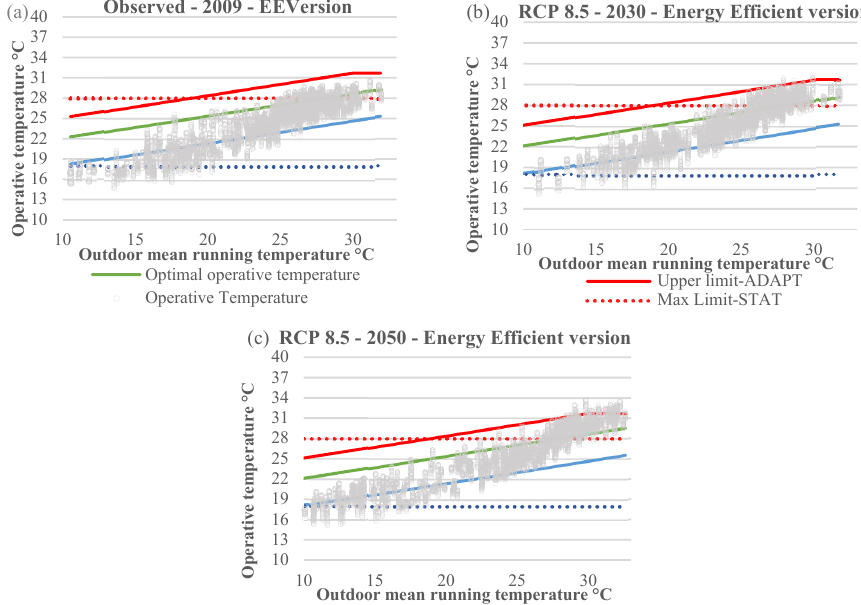
Figure 7. Climate change impact on an energy-efficient version of a residence in Paraguay considering RCP 8.5 [14]. ( a ) For 2009 year; ( b ) For 2030 year ; ( c ) For 2050 year.